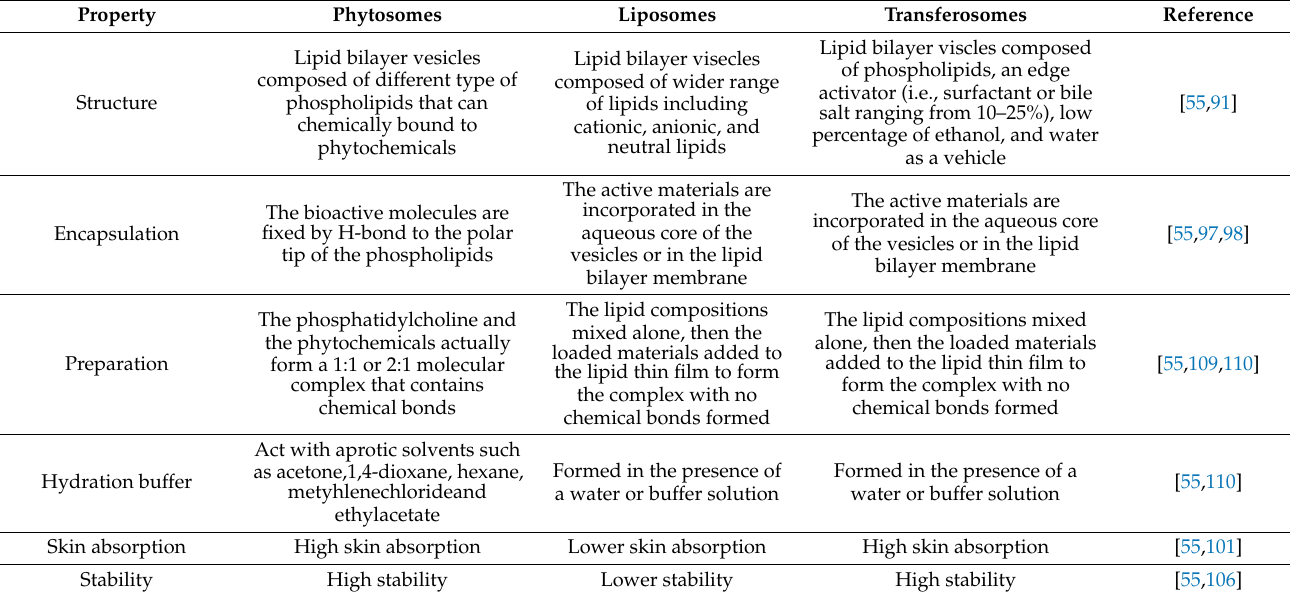
Table 3. Key similarities and differences in the features of different lipid-based drug delivery systems that commonly used in the topical delivery of herbal